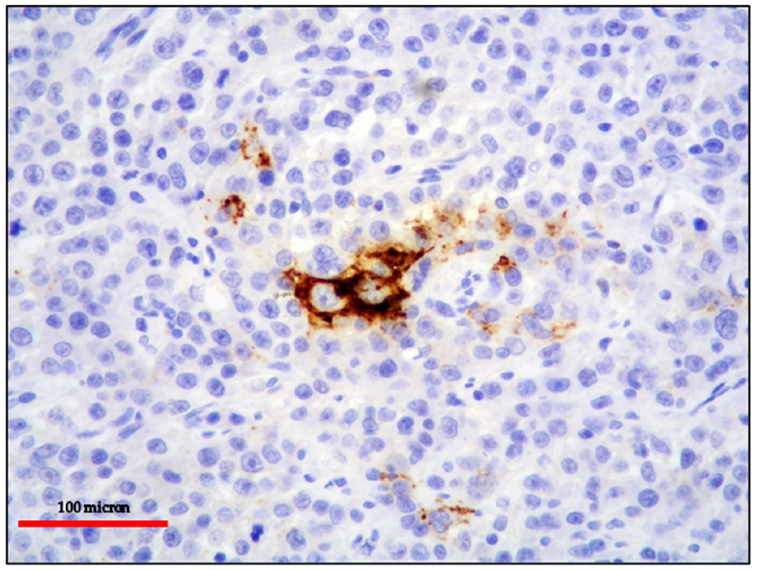
Figure 3. PBL of the colon: the lack of B-cell marker expression is a feature common among neoplasms with plasma cell differentiation such as PBL and PEL (CD20 immunostaining, Ventana immunostainer, magnification 400×; original image from Prof Ascani).